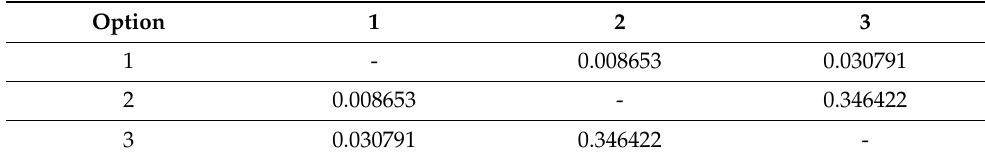
Table 2. Comparison of the difference between the measurement after 1 regeneration and the measurement after 8 regenerations—Fisher’s